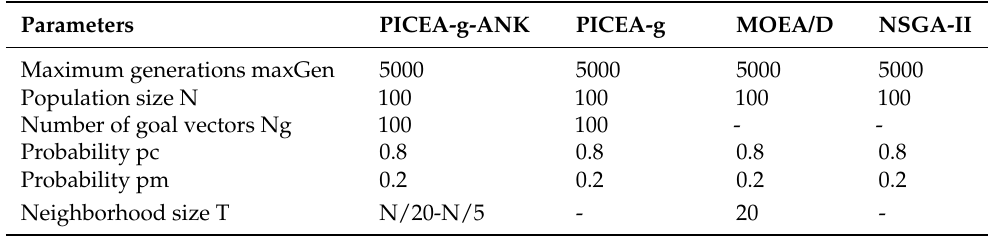
Table 12. Algorithm